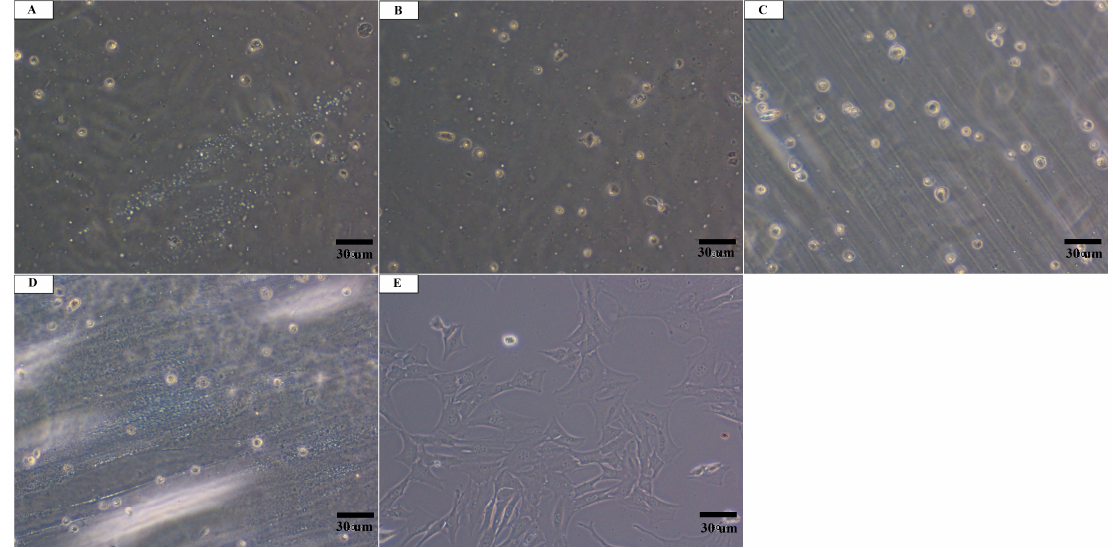
Figure 4. Culture of Balb/3T3 fibroblasts 24 h after application of the cells on the surfaces of the materials: ( A ) Ref, ( B ) F 1 , ( C ) F 2 , ( D ) F 3 , and ( E ) control cell culture without contact with the material No cell colonization of the material surfaces was observed. Magnification: ×100.